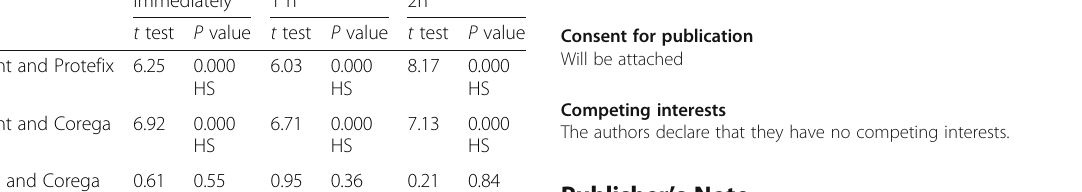
Table 3 Comparison of effectiveness among the denture adhesives at each time intervals (Student ’ s paired t test)